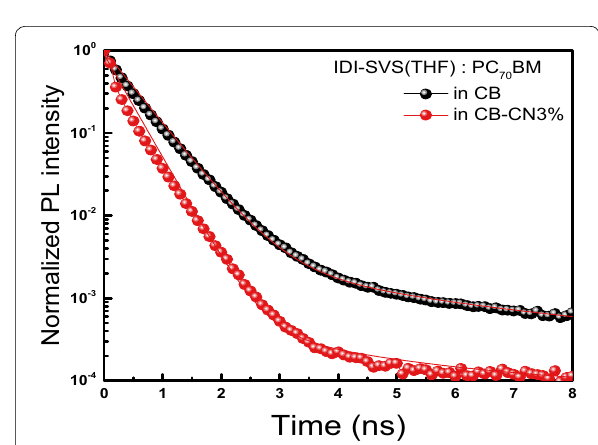
Fig. 5 TCSPC results of P‑IDI‑SVS(THF):PC 70 BM measured with different solvents (CB, CB–CN3%)